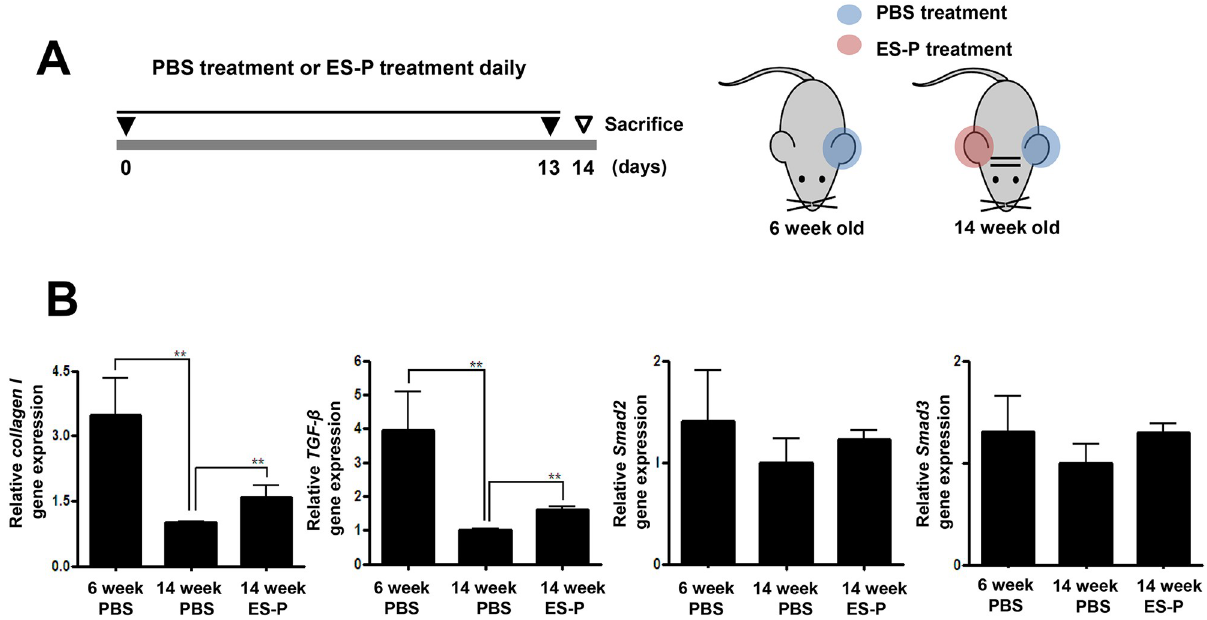
Fig 1. Expression levels of type I collagen, Smad2/3, and TGF- β 1 genes after ES-P treatment in aged mice. (A) The left ears of fourteen-week old mice were treated daily with 30 μ g T . spiralis ES-P for 14 days (red color). The right ears of were treated daily with PBS for 14 days as control (blue color). After 14 days, ears were collected. Total RNA was extracted from each ear tissue and cDNA was constructed. (B) The gene expression levels of collagen I , TGF- β 1 , and Smad2/3 were analyzed by real-time PCR. The gene expression value of each group was normalized by control value, 14 weeks group. ( �� ; P < 0.01, n = 5 mice/group, these were representative results from three independent experiments).